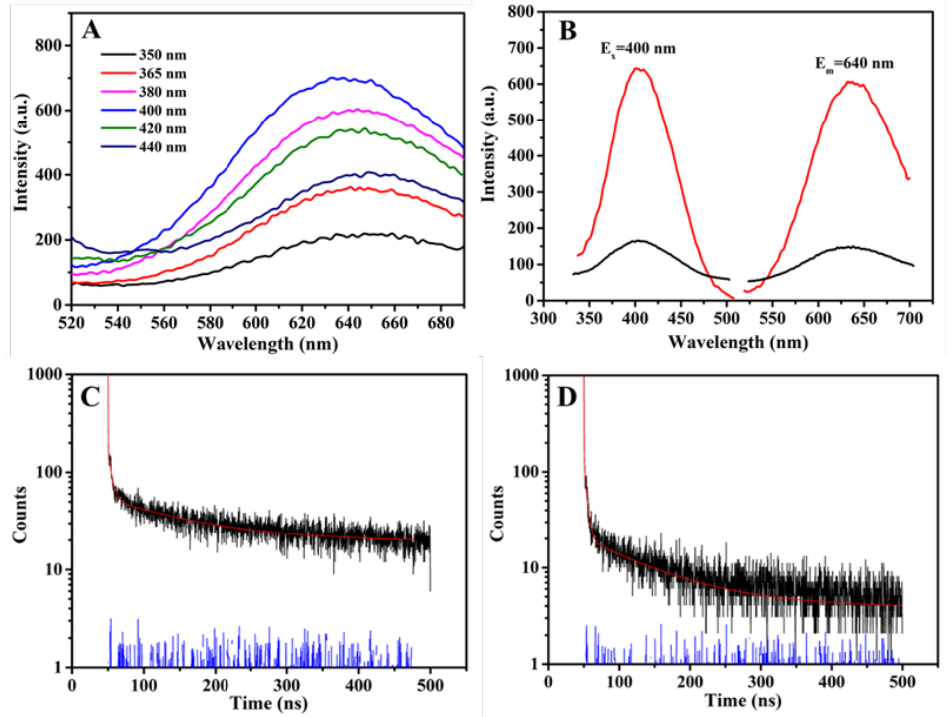
Figure 3. ( A ) Emission spectra of LA − Cu NCs@CS with different excitation wavelengths ( B ) Excita- tion and emission spectra of LA − Cu NCs (black line) and LA − Cu NCs@CS (red line). Time − resolved fluorescent decay spectra of ( C ) LA − Cu NCs and ( D ) LA − Cu NCs@CS.